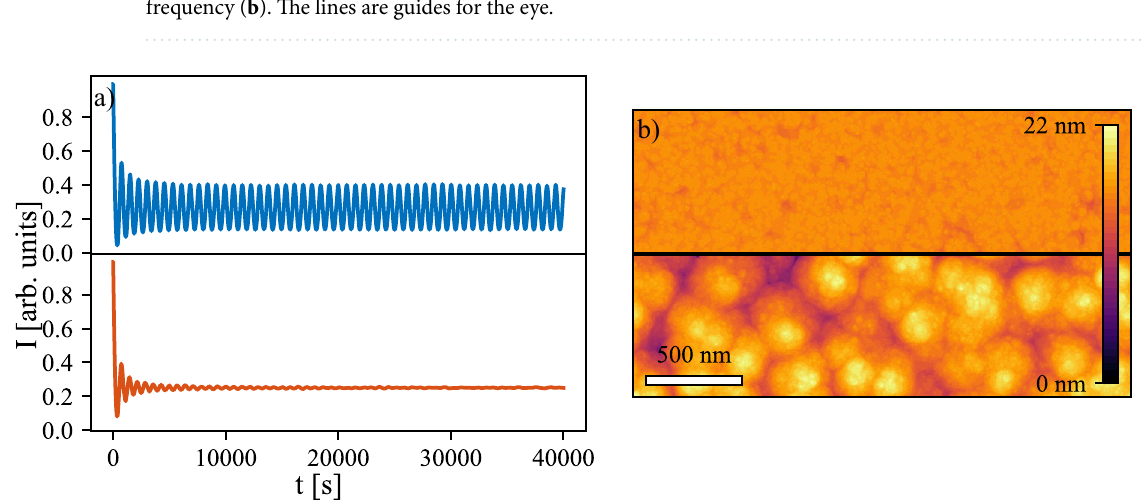
Figure 7. ( a ) The comparison of AB intensities and ( b ) morphologies obtained for nominal temperature obtained from 5 Hz simulations (top) and for corrected temperature obtained from 1 Hz simulations